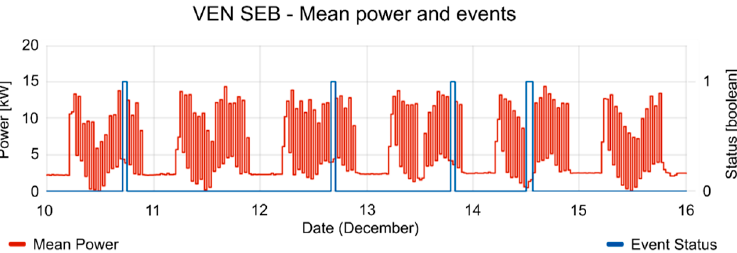
Figure 13. Mean power and event status (where 1 is active and 0 is inactive) during the test period.